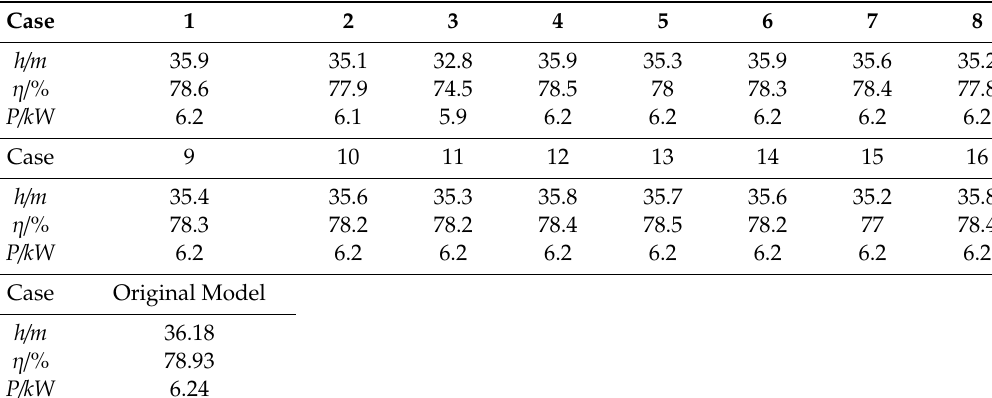
Table 6. 1.0 Q numerical simulation results.